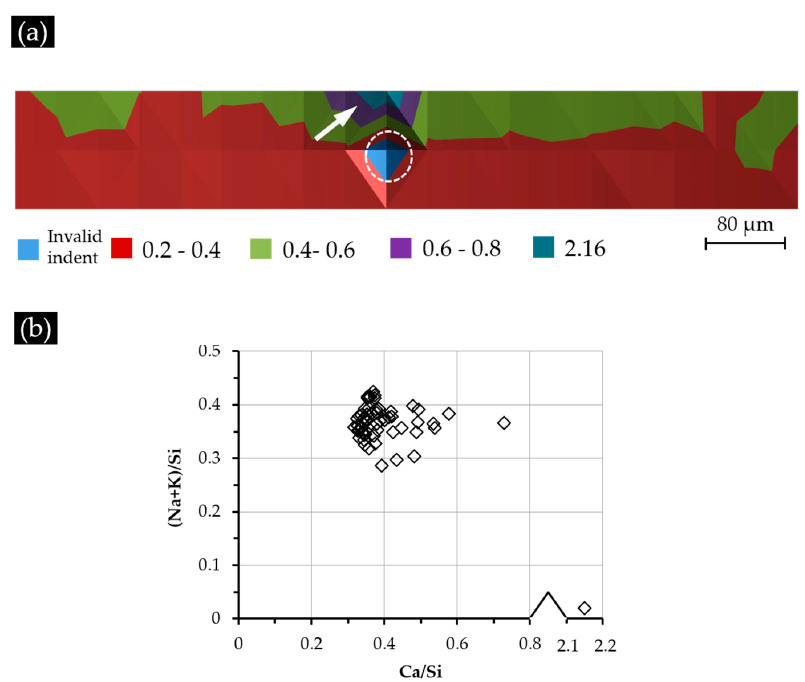
Figure 12. ( a ) The Ca/Si ratio variation of the indented areas from S2; ( b ) the elemental composition of the indented areas.